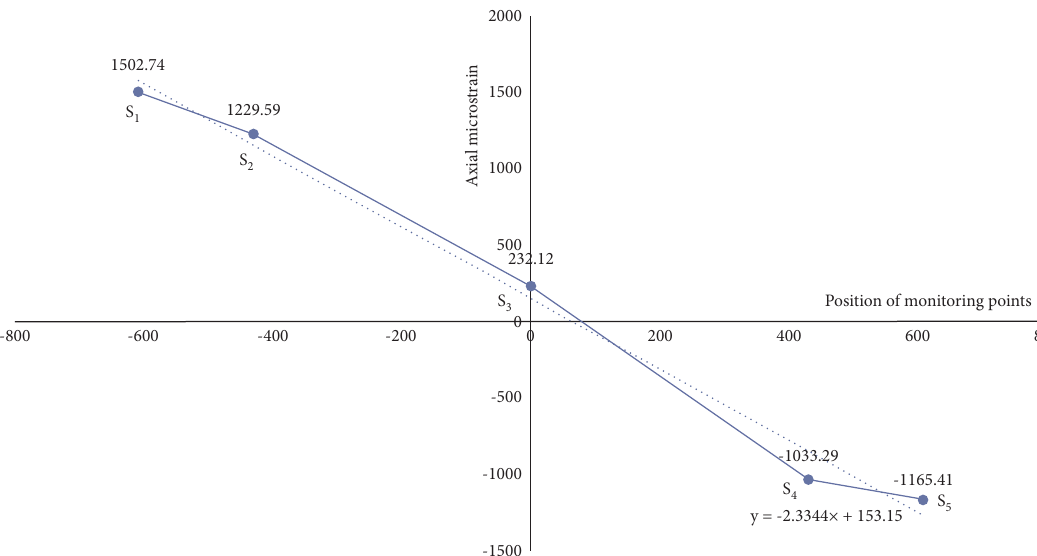
Figure 14: Trend line fitted by 5 monitoring points in pipe section 1 utilizing the least square